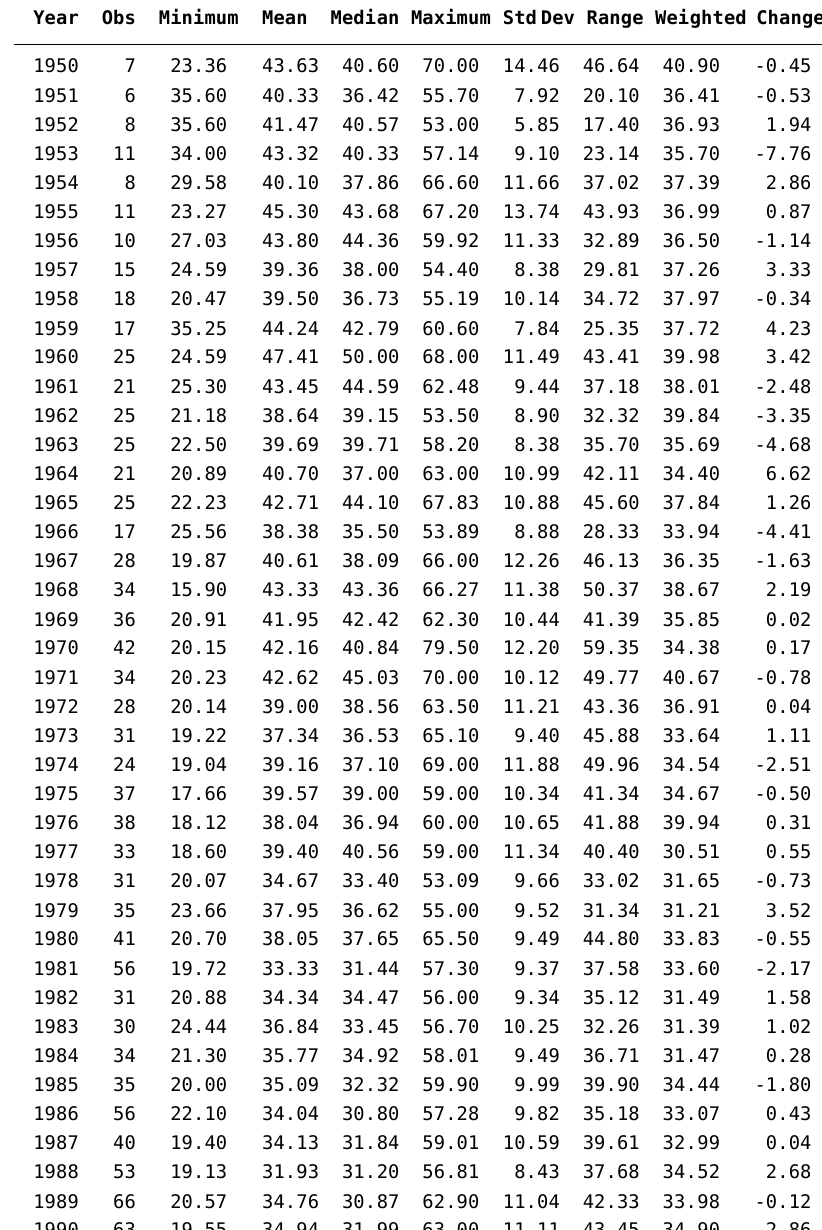
Table 1 – Statistical Summary of the World Income Inequality Database (WIID) Variable